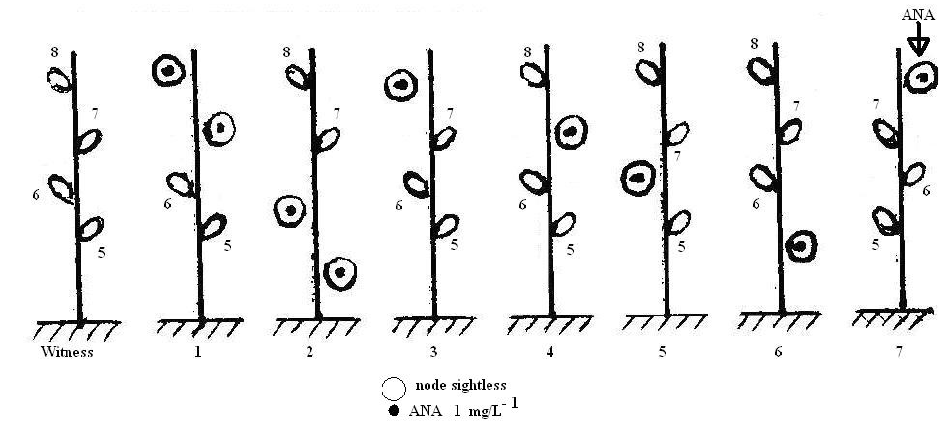
Fig. 1. Experimental model